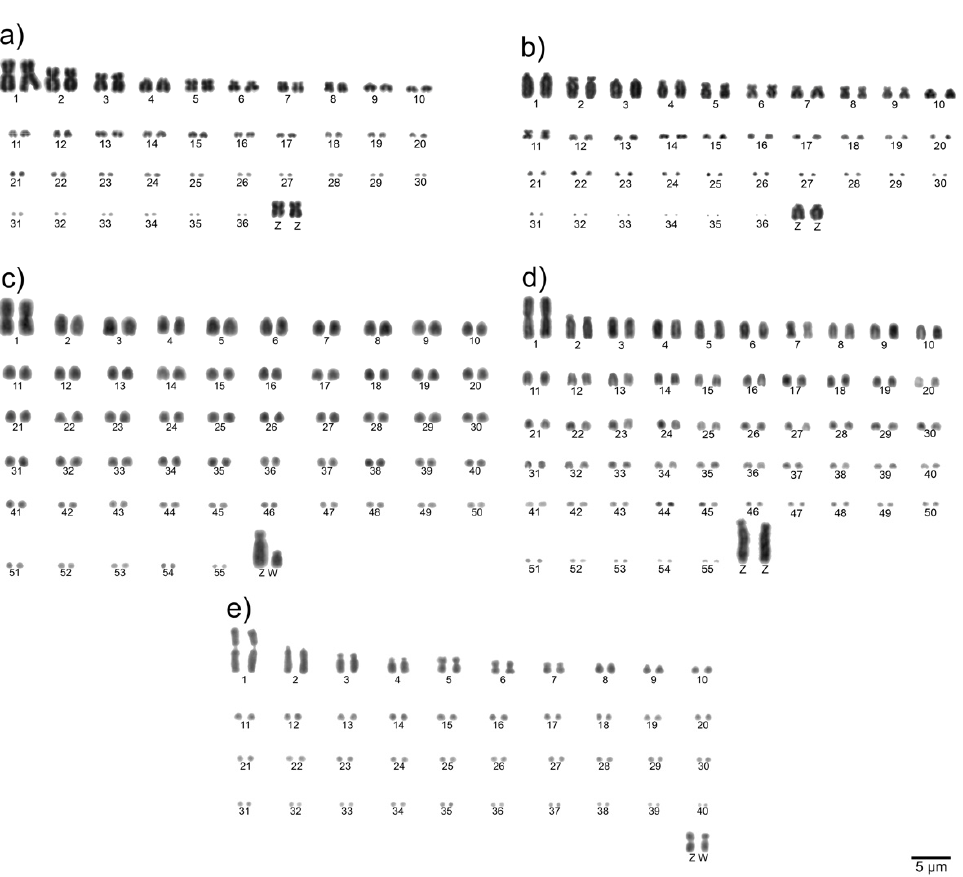
Figure 1. Complete Giemsa-stained karyotypes of Phalacrocorax brasilianus ( a ), Hydropsalis torquata ( b ), Pteroglossus inscriptus ( c ), Ramphastos tucanus tucanus ( d ), and Trogon surrucura surrucura ( e ).